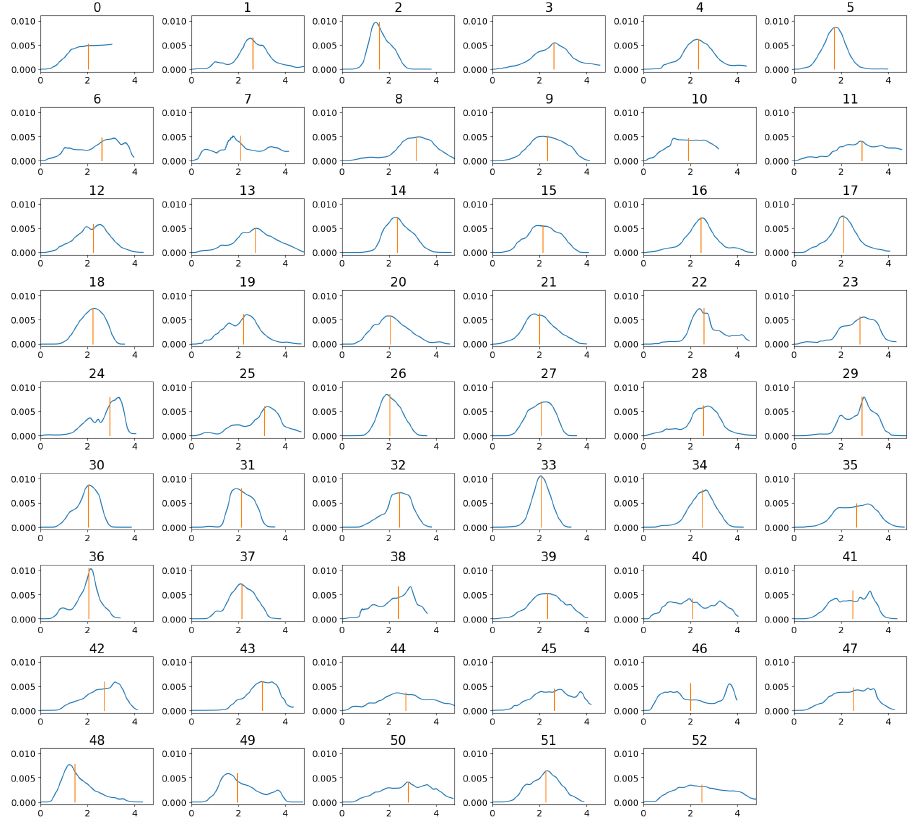
Figure 4. Distribution of attention weights extracted from each gesture (1–52, 0 = resting state) in the training set for the Att300 model. The vertical orange line corresponds to the median, and the x-axis is time in